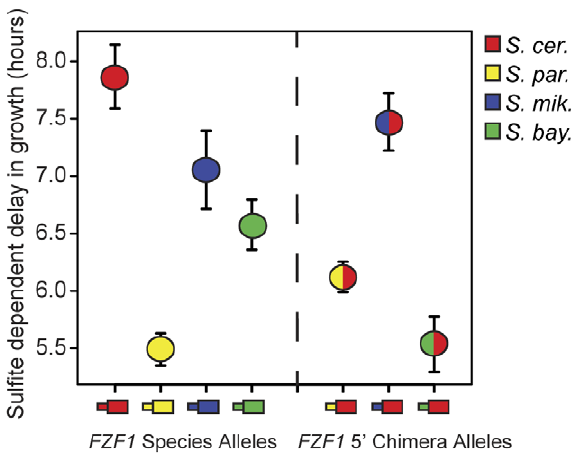
Figure 2. FZF1 alleles from different species have diverged in function. The left side of the figure shows sulfite resistance of FZF1 alleles from four different species: S. cerevisiae (red), S. paradoxus (yellow), S. mikatae (blue), and S. bayanus (green) in an S. cerevisiae strain background. The right side of the figure shows sulfite resistance of chimeric alleles of FZF1 composed of the 5 9 noncoding region from S. paradoxus , S. mikatae and S. bayanus combined with the S. cerevisiae coding region. Error bars show the 95% confidence interval of the mean.